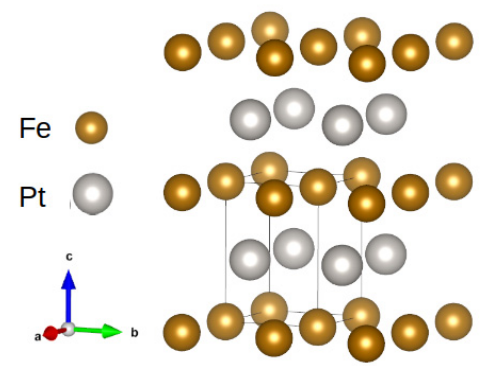
Figure 4. Crystal structure of the L1 0 FePt phase.